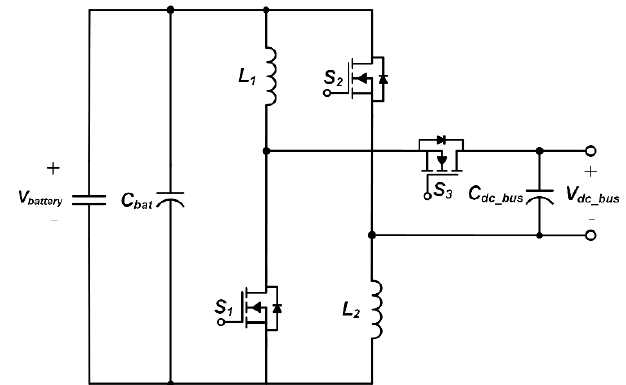
Figure 3. A single-stage bidirectional DC–DC converter.